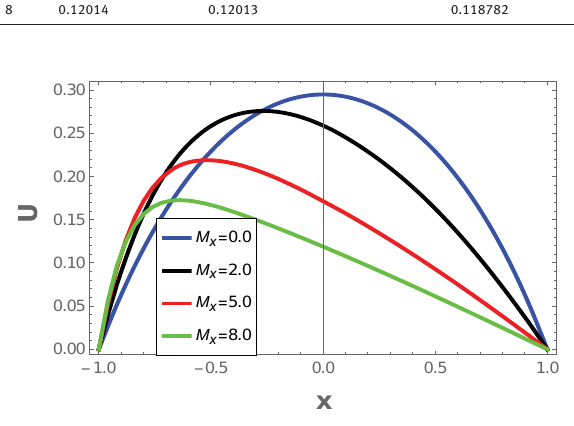
Figure 4: The profile of velocity with Hartmann numbers 0 (top curve), to 8 (bottom curve).